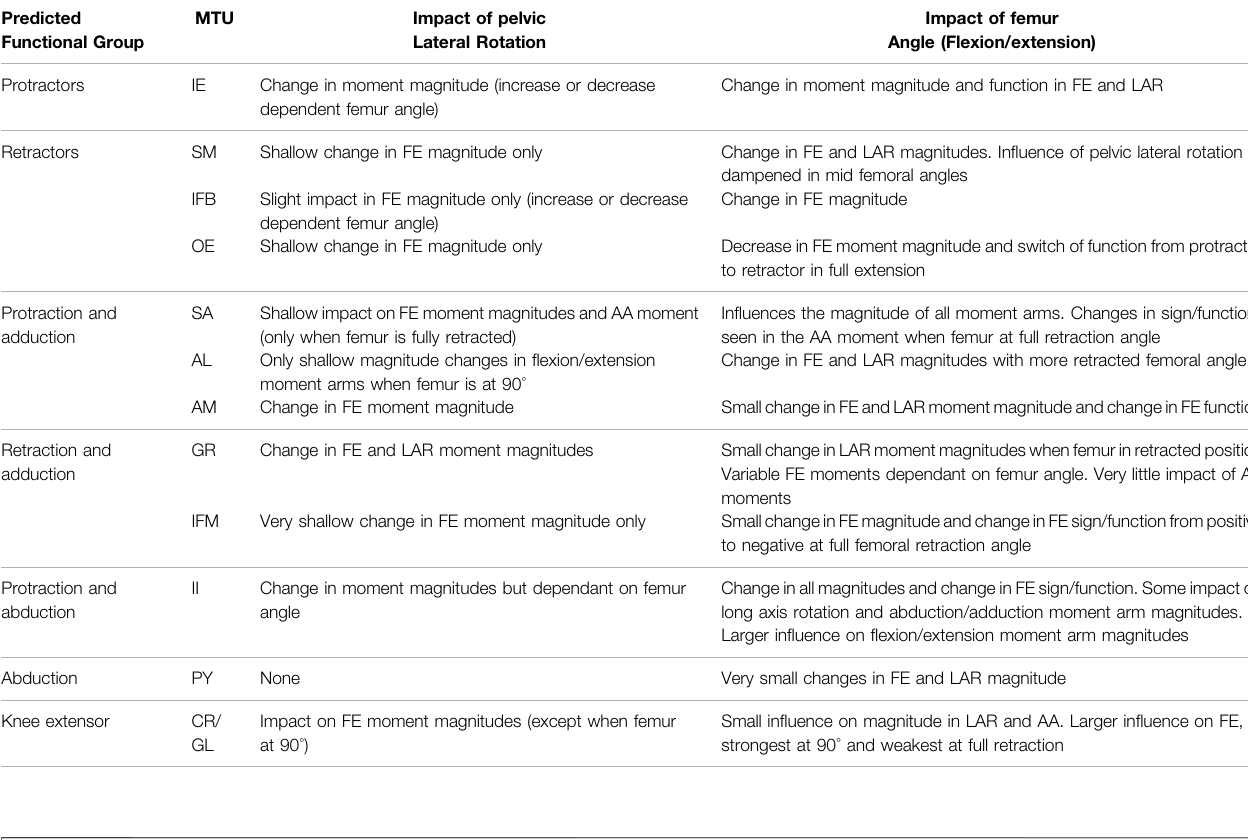
TABLE4| ResultsofhypotheticalsimulationsHYP_01-HYP_06describingthein fl uenceofpelviclateralrotationandfemurangleinthe fl exion/extensionplaneonthe fl exion/ extension (FE), long axis rotation (LAR), and abduction/adduction (AA) moment arms of the hindlimb muscles.